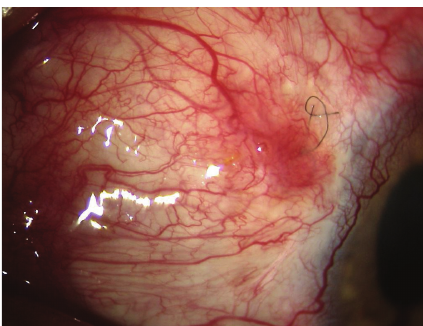
Figure 4: The bleb as it appears 6 months after surgery. A deep suture that could not be easily removed is still visible under the